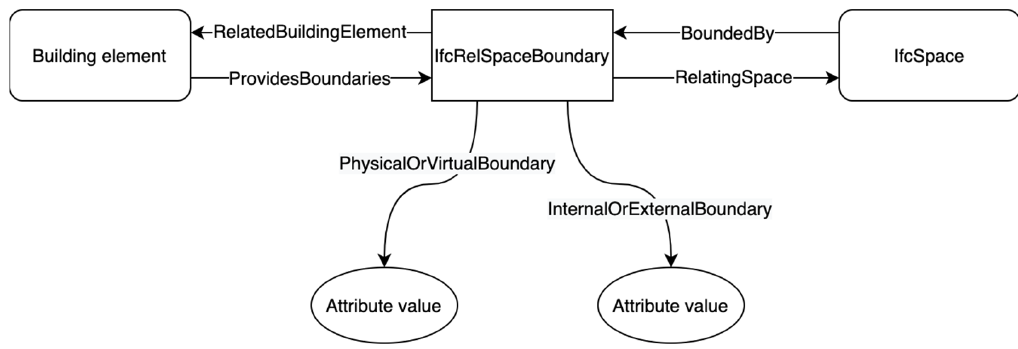
Figure 6. Relationship between building element, 𝐼𝑓𝑐𝑅𝑒𝑙𝑆𝑝𝑎𝑐𝑒𝐵𝑜𝑢𝑛𝑑𝑎𝑟𝑦 and 𝐼𝑓𝑐𝑆𝑝𝑎𝑐𝑒 . Table 4. Criteria for differentiating roofs, floors, external slabs, and base slabs.